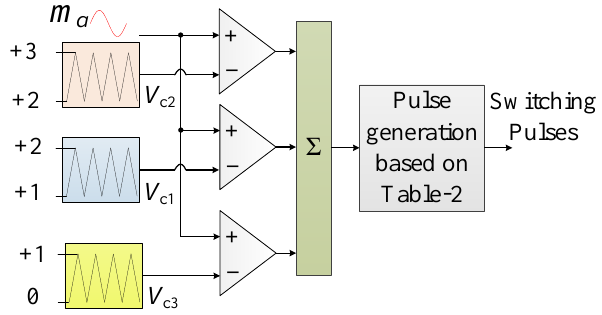
Figure 7. Level shifted PWM signals for phase-a.